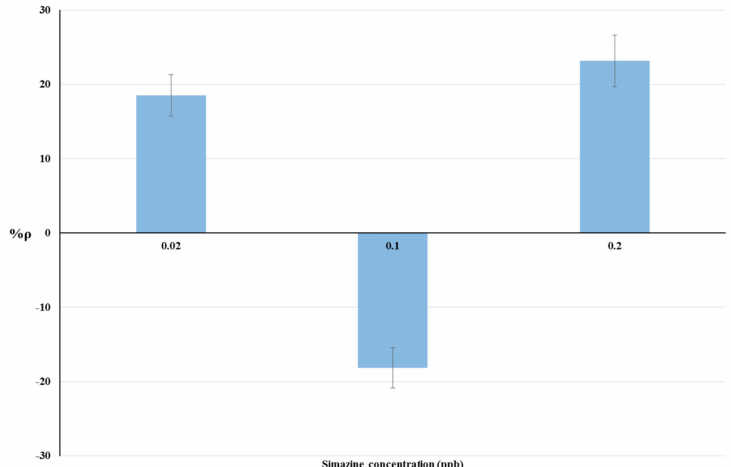
Figure 3. Dose-effect histograms for 2 h exposure to simazine in livestock drinking water samples. %RSD ≤ 15%; ANOVA testing using Randomized Block Design was applied for statistical differences